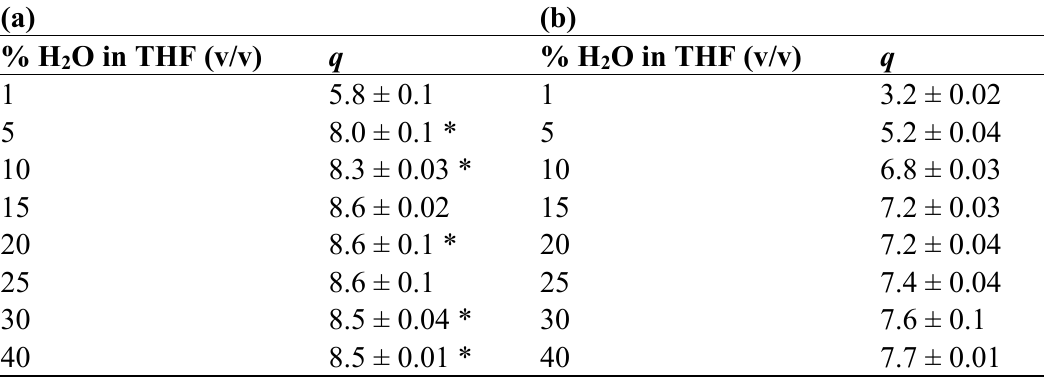
Table 1. Mean water-coordination numbers ( q ) of (a) Eu(OTf) O/THF. Error represents standard error of the mean of between 3 and mixtures of H 2 9